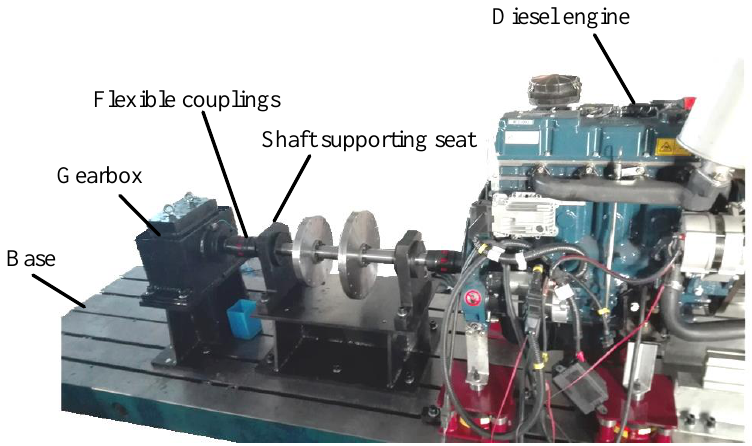
Figure 16. Platform of multi-fault gearbox. Table 1. Gear parameters of the test gearbox.